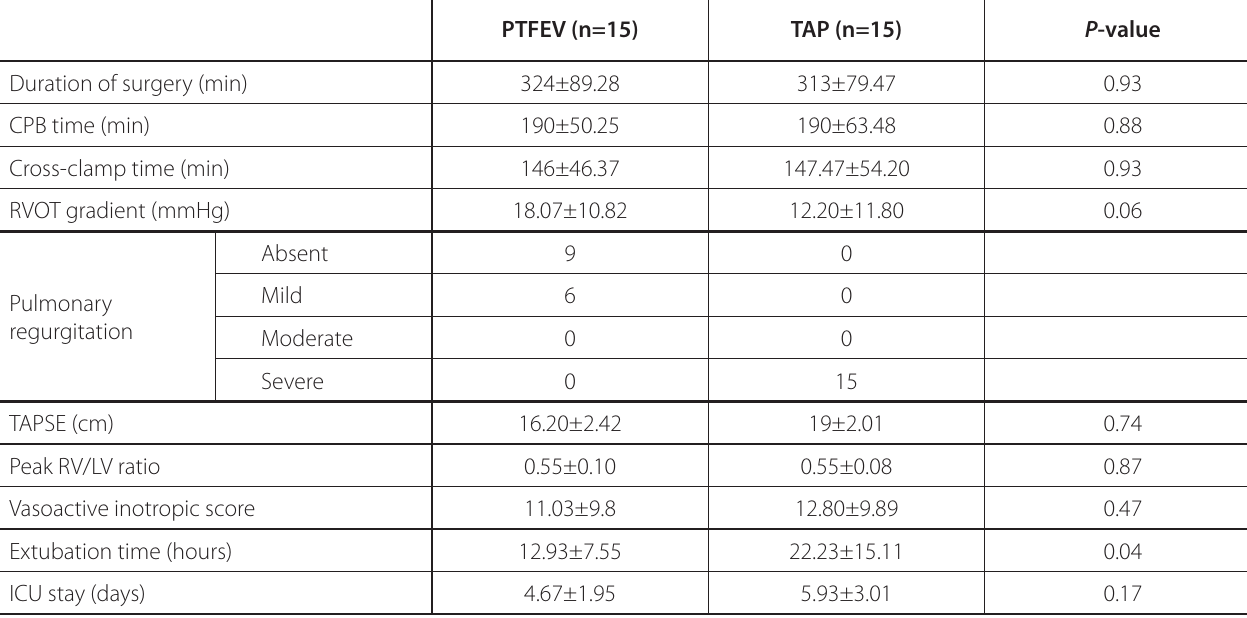
Table 4 . Intraoperative and postoperative immediate